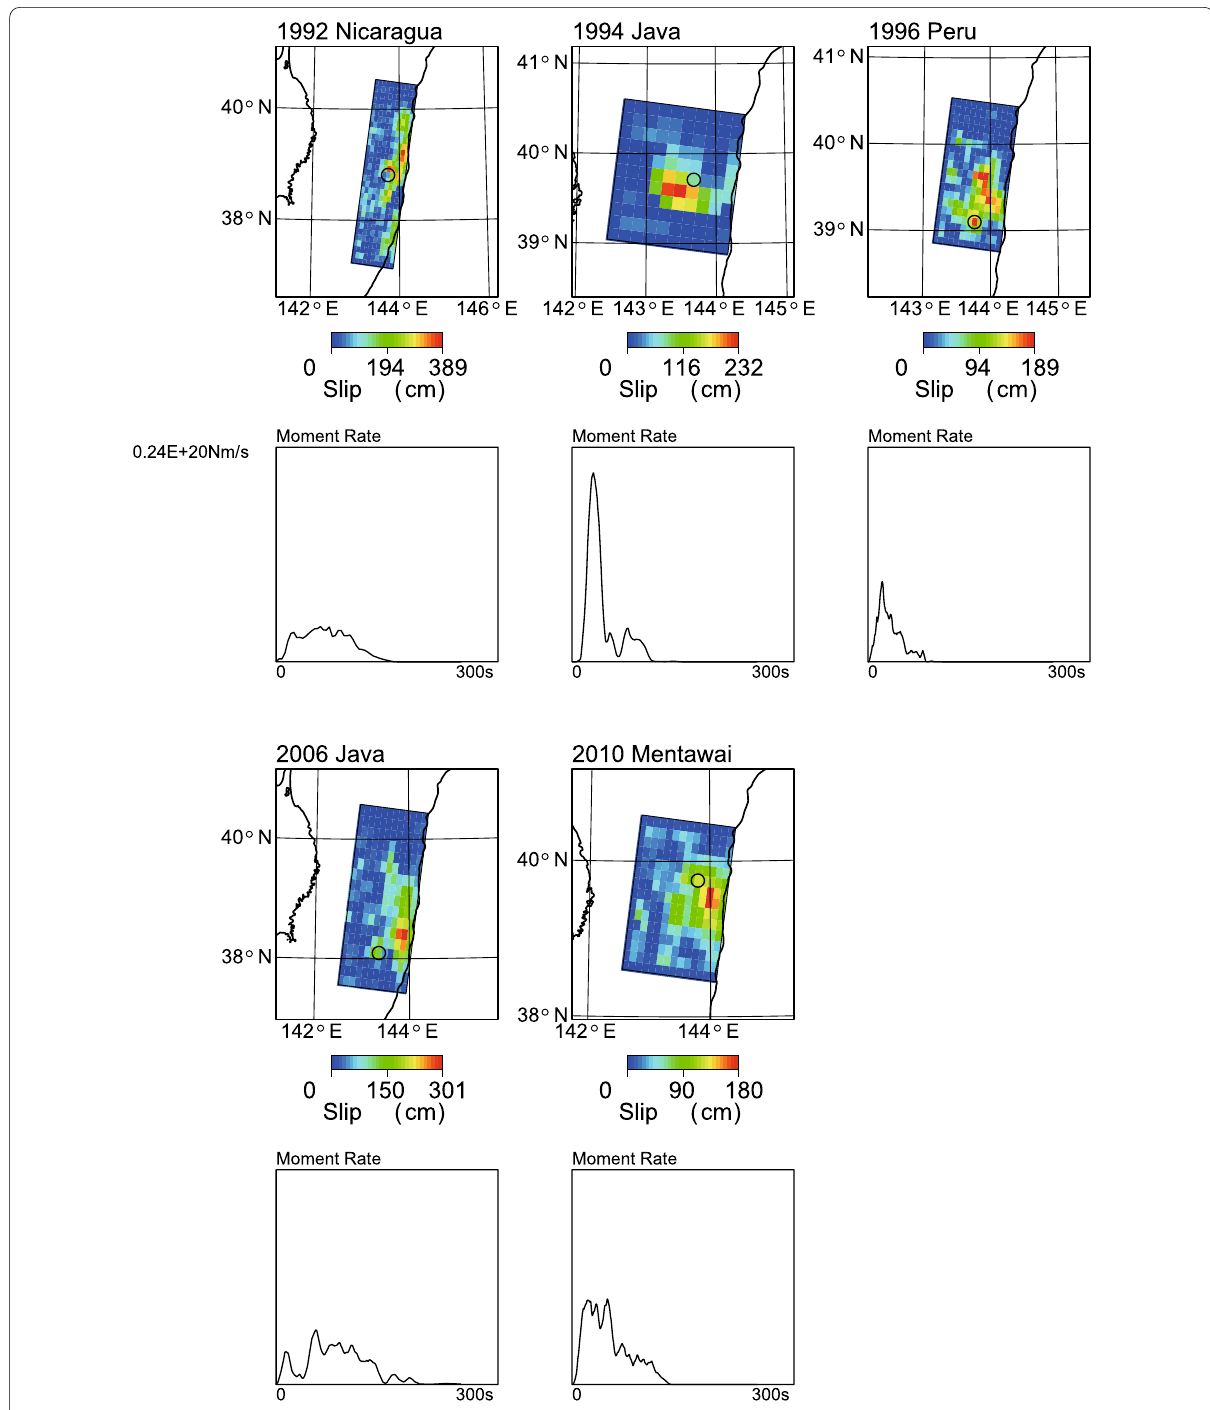
Fig. 8 (Upper) The finite fault models (U. S. Geological Survey 2020) used to test proposed magnitudes. The five tsunami earthquakes were assumed to occur off Tohoku, Japan. On each map, the circle indicates the epicenter. The various magnitudes were estimated (Table 2) for synthetic records calculated with these fault models. (Lower) Source time function of each